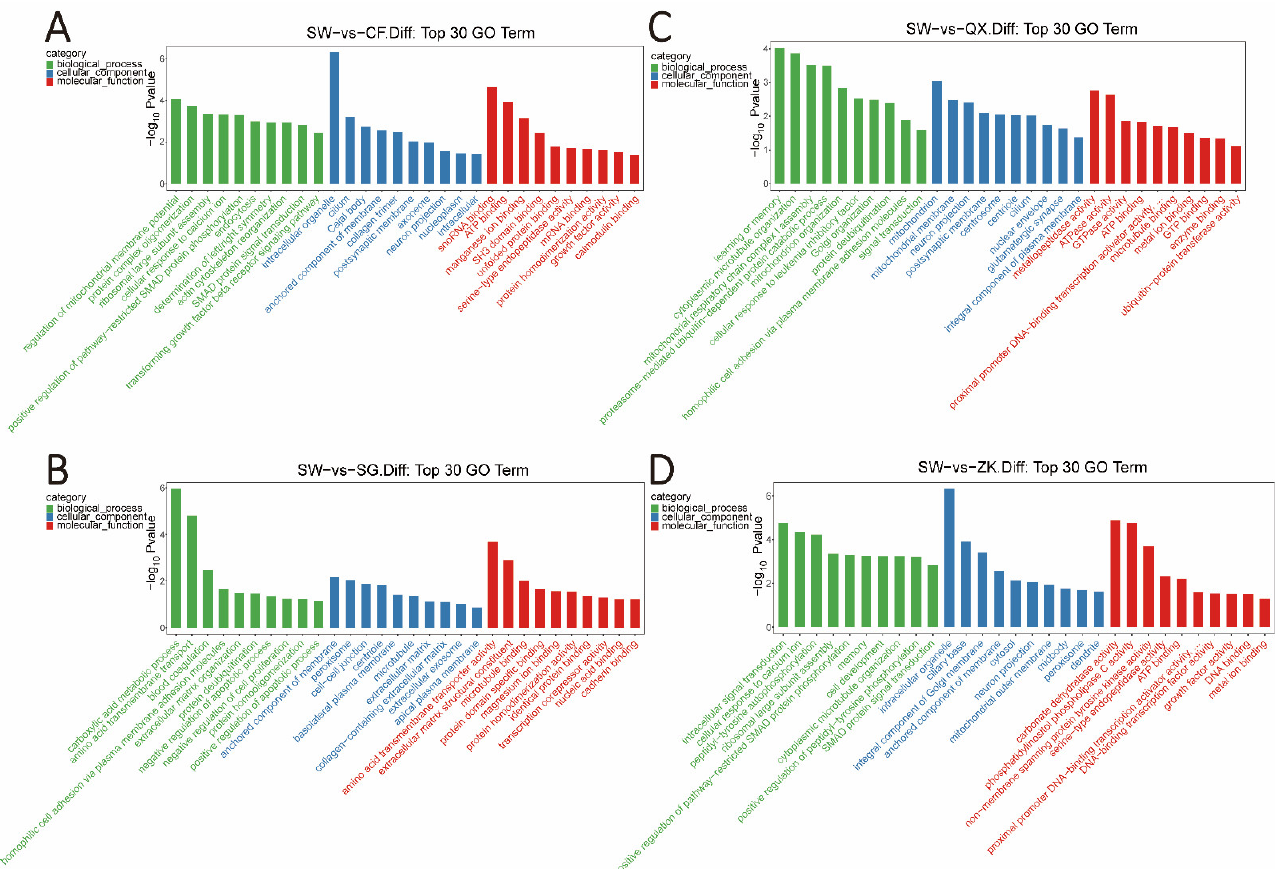
Figure 4. GO enrichment analysis was performed for genes containing SNPs identified by outlier analysis. ( A ) Top 30 GO terms for SW and CF. ( B ) Top 30 GO terms for SW and SG. ( C ) Top 30 GO terms for SW and QX. ( D ) Top 30 GO terms for SW and ZK.